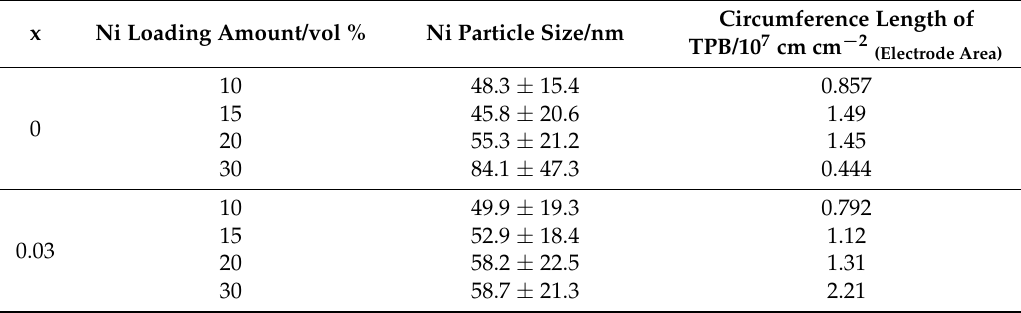
Table 1. Ni particle size and circumference length of triple phase boundary (TPB) of Ni/BCZYN (x = 0 and